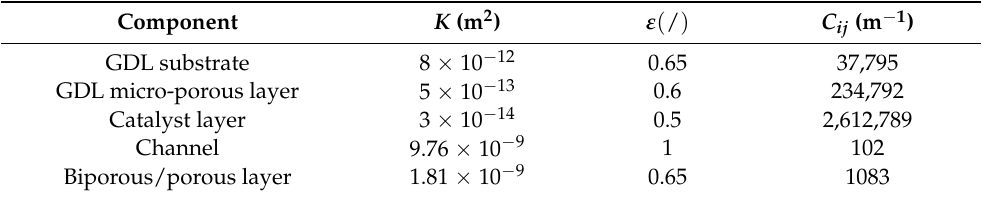
Table 4. Values of inertial resistance term including the Forchheimer effect for PEM fuel cell components.